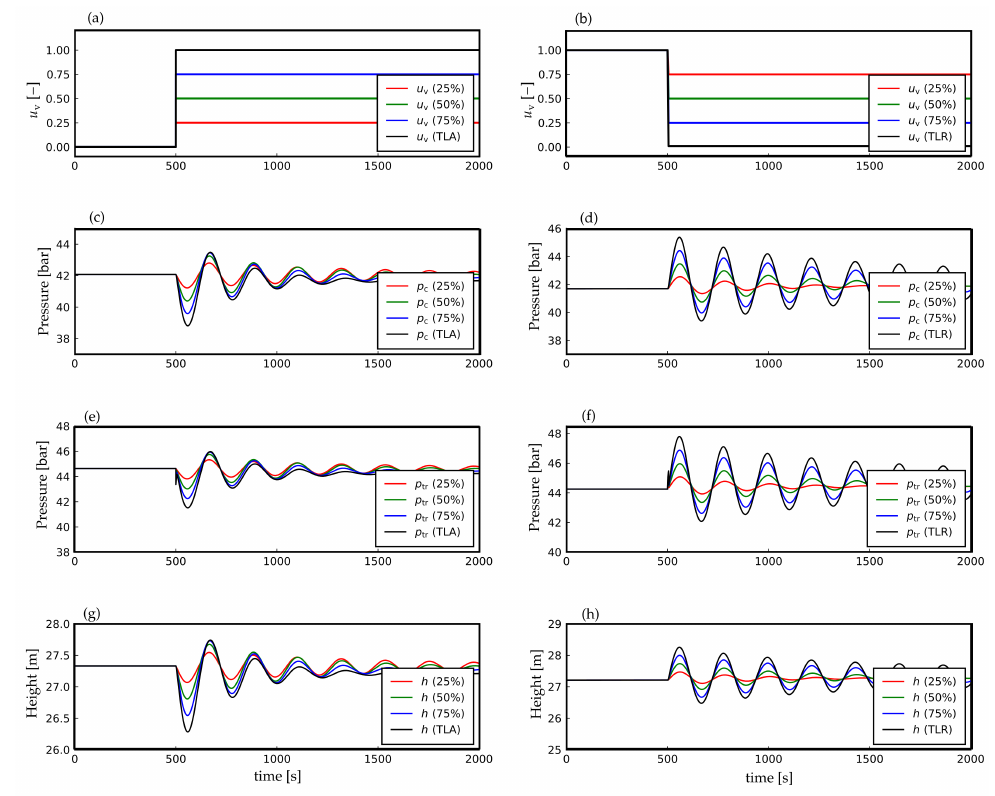
Figure 7. Hydraulic performance of the ACST for Torpa HPP for the different percentage change in the load acceptances and the load rejections, ( a ) turbine valve signal u v as an input to the load acceptances, ( b ) turbine valve signal u v as an input to the load rejections, ( c ) air pressure p c for